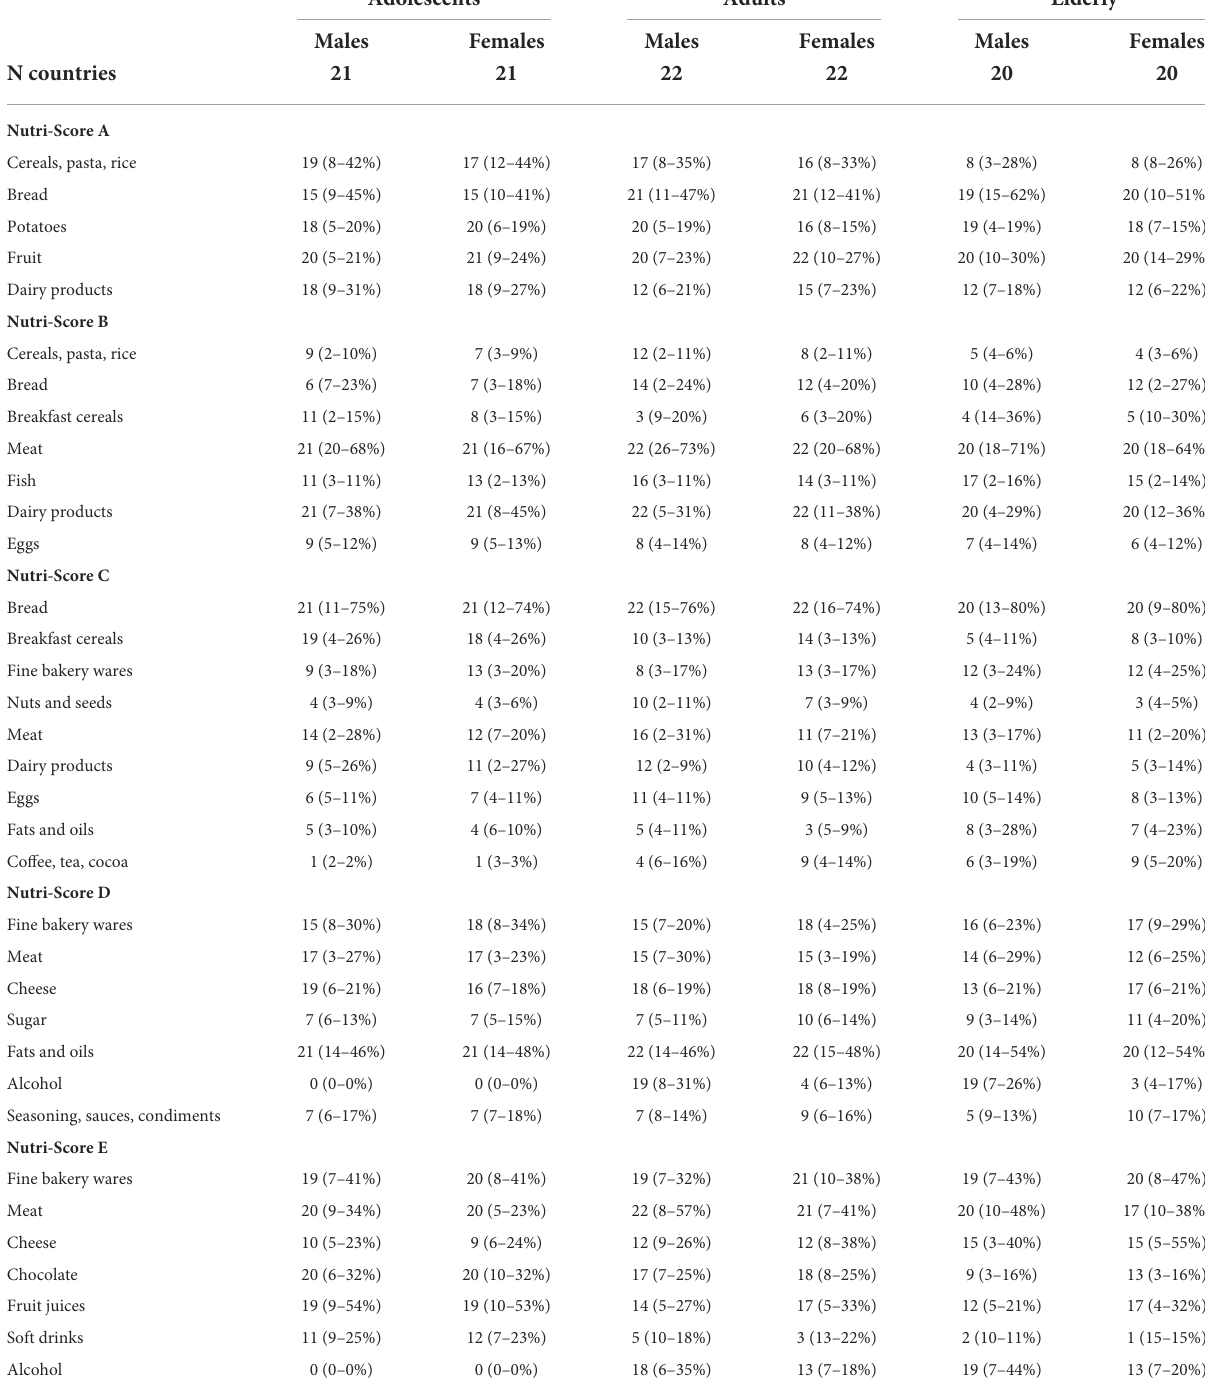
TABLE 1 Main five food group contributors a to the A, B, C, D, and E Nutri-Score ranks in Europe by age-groups and